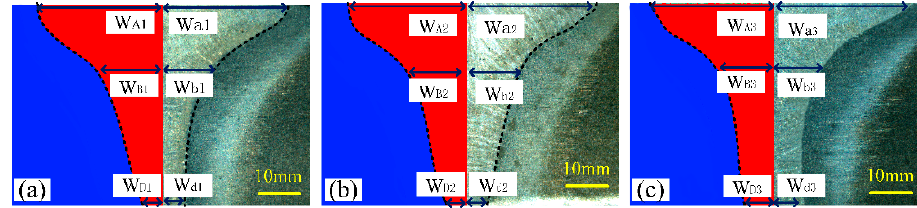
Figure 6. Comparison of simulated cross-sectional profile and experimental cross-sectional profile: ( a ) laser power 7 kW, ( b ) laser power 7.5 kW, ( c ) laser power 8 kW.